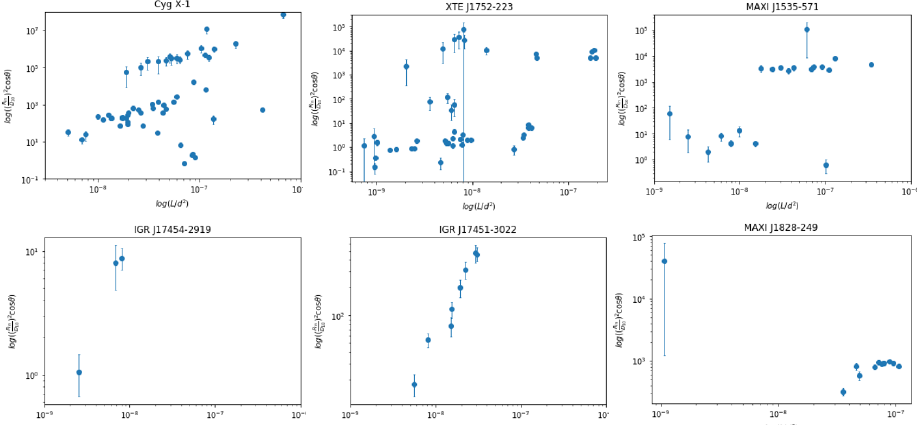
Fig. 9. The luminosity and the innermost radius relations. Since we do not have the distance and the inclination of the disk, we used normalization of diskbb which is correlated to (R in /D 10 ) 2 cos θ